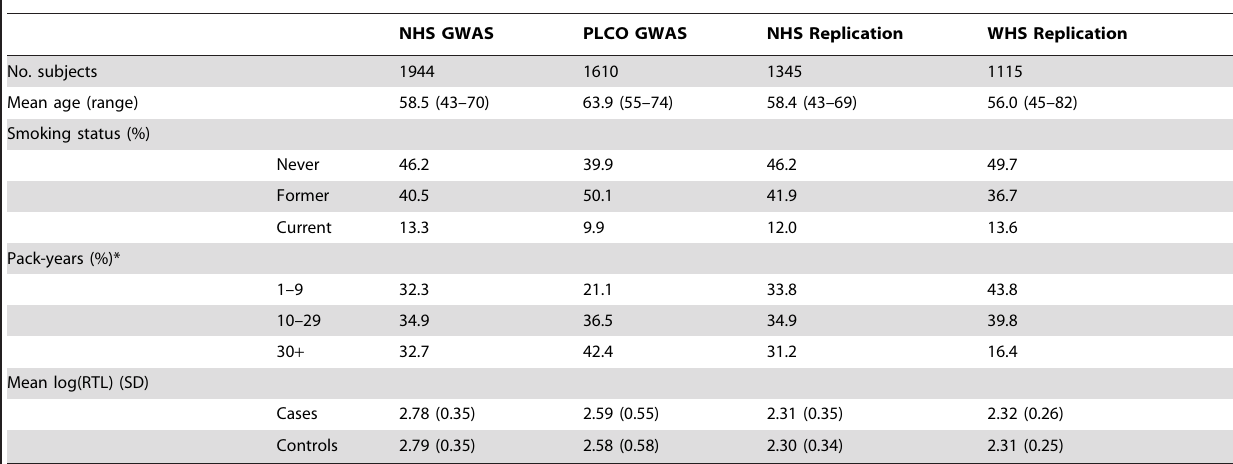
Table 1. Characteristics of GWAS and replication